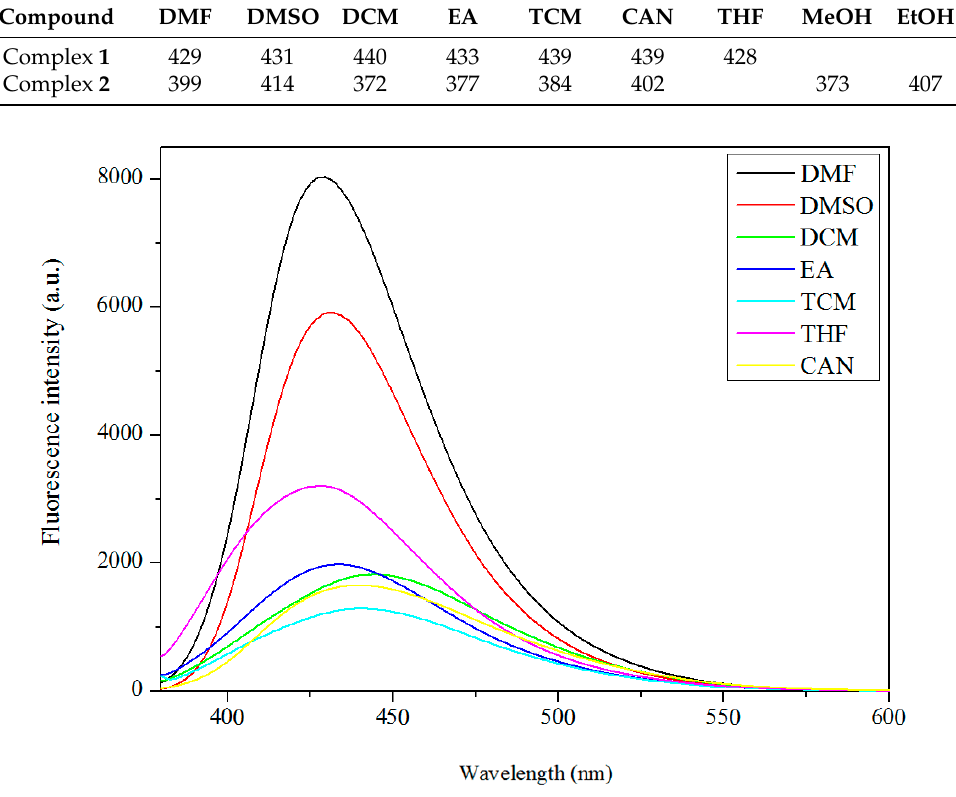
Figure 9. Absorption spectra of HL 2 in DMF solutions upon the addition of Zn 2+ . Inset: The absorbance Table 7. The maximum fluorescence emission in difference solvents for complexes 1 and 2 . at 380 nm varied as an interaction of [Zn 2+ ]/[HL 2 ].